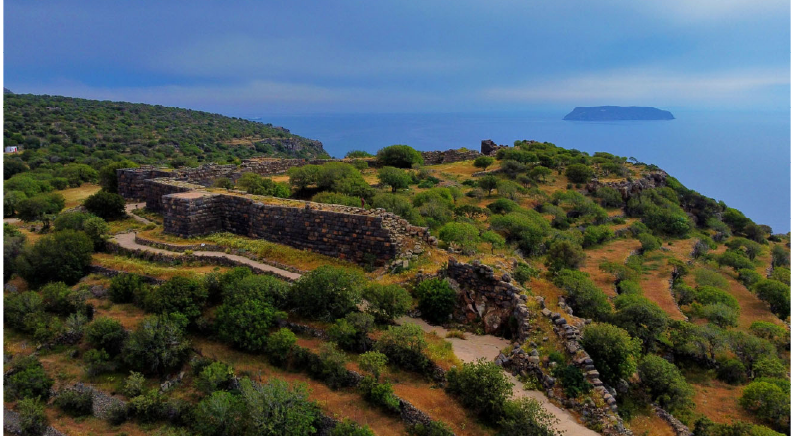
Figure 6. Palaiokastro, the acropolis of the ancient Greek town of Nisyros, stands today as the best-preserved fortress of the Classical Period. Built by huge volcanic blocks, it is a representative example of the everlasting connection between this volcanic landscape and its inhabitants throughout millennia.